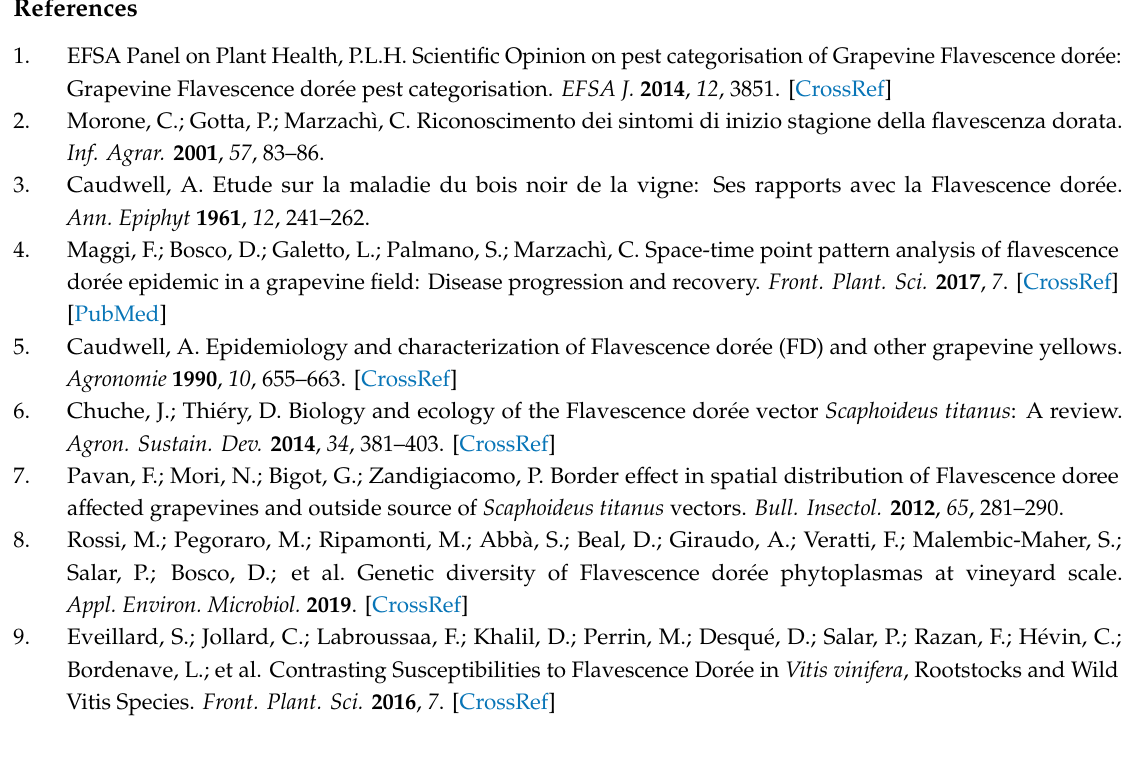
Table S1: Climatic data of May–September 2015. Table S2: Scaphoideus titanus adults collected by yellow sticky traps inside and outside the seven investigated